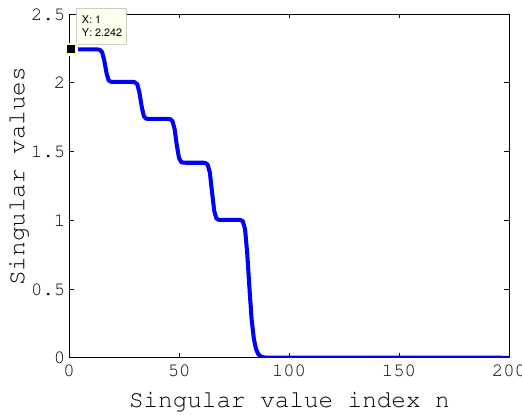
Figure 4: A comparison between the metric entropy evalu- ated from the exact singular values and the one estimated by the equations (8) for the view diversity when I = [ − 10 , 10] m, Ω o = [ − 1; 1] and M = 3